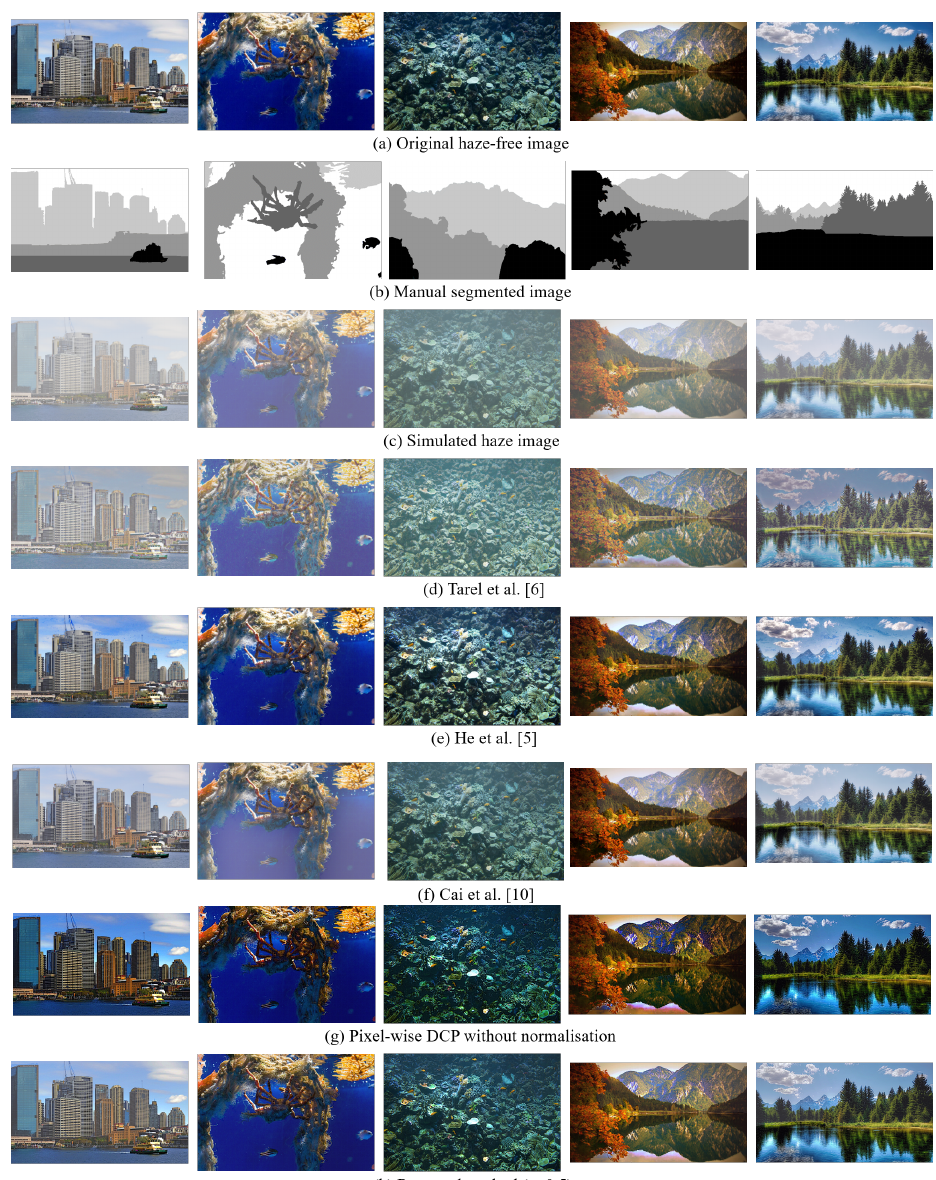
Figure 8. Comparison of proposed method with conventional method using simulated haze image generated with nonuniform transmission map. ( a ) Original haze-free image, ( b ) Manual segmented image, ( c ) Simulated haze image, ( d ) Tarel et al. [6], ( e ) He et al. [5], ( f ) Cai et al. [10], ( g ) Pixel-wise DCP without normalisation, ( h )Proposed method ( γ =